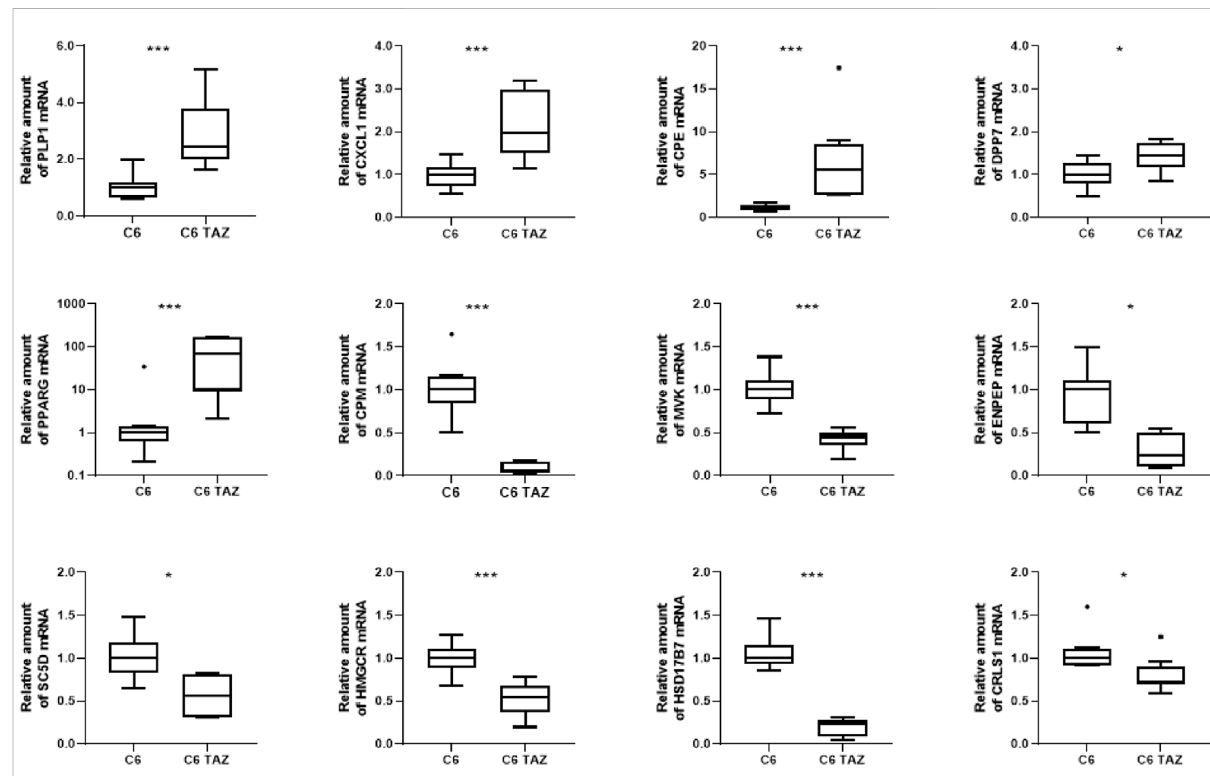
FIGURE 2 Tafazzin de fi ciency alters gene expression in C6 cells: Quanti fi cation levels of indicated genes in C6 and C6 TAZ cells was preformed and the amount of mRNA was determined by using RT-qPCR and normalized to RPL13a. Data is given as boxplot with median, quartile, and interquartile range (* p < 0.05; ** p < 0.01; *** p < 0.001). Outliers are indicated using Tukey method. n =